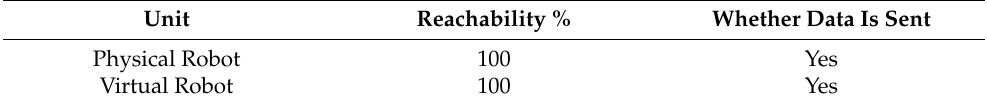
Table 5. Experimental